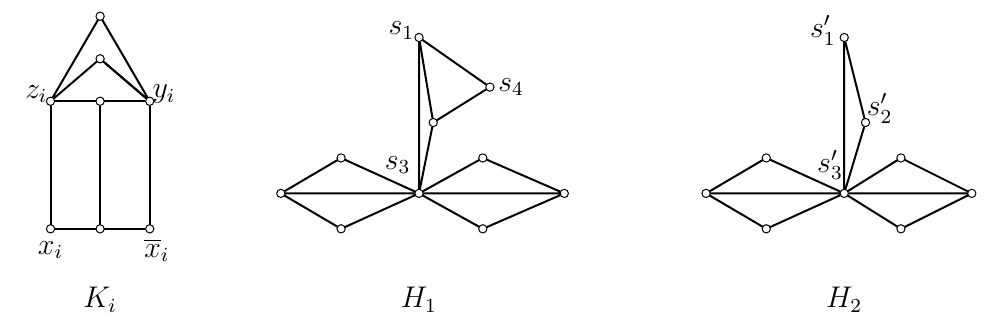
Figure 1: The graphs K